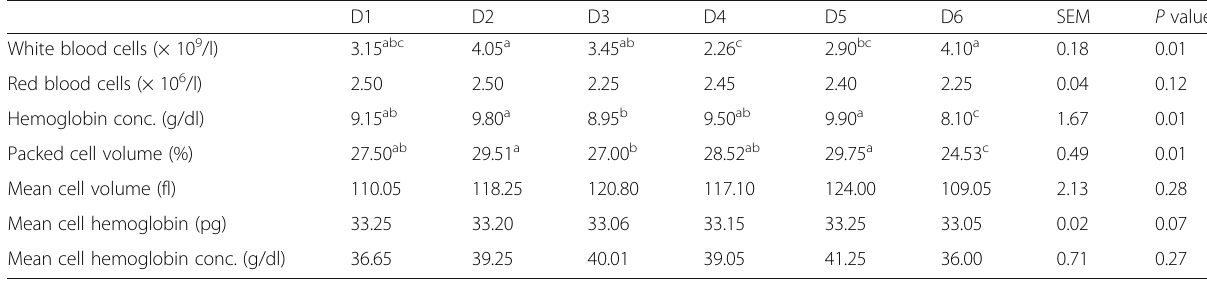
Table 3 Effects of pawpaw leaf and seed meal composite mix (PCM) supplementation on hematological indices of broiler chickens